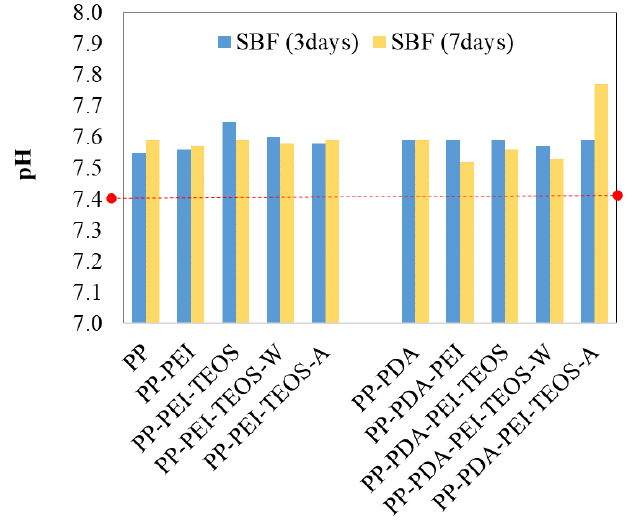
Figure 4. pH values of SBF medium after 3 and 7 days of films’ incubation. The initial pH of the prepared SBF was 7.4 (red dotted line).